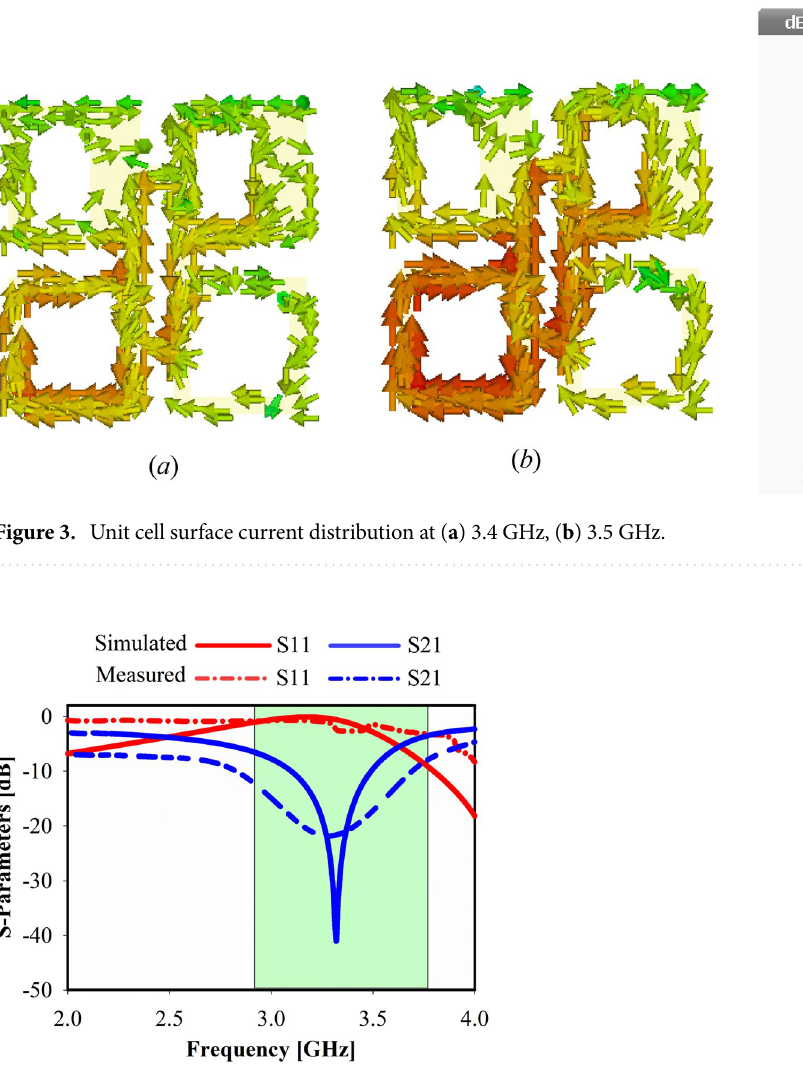
Figure 4. Metamaterial (MTM) s-parameters at the z-axis: measured and